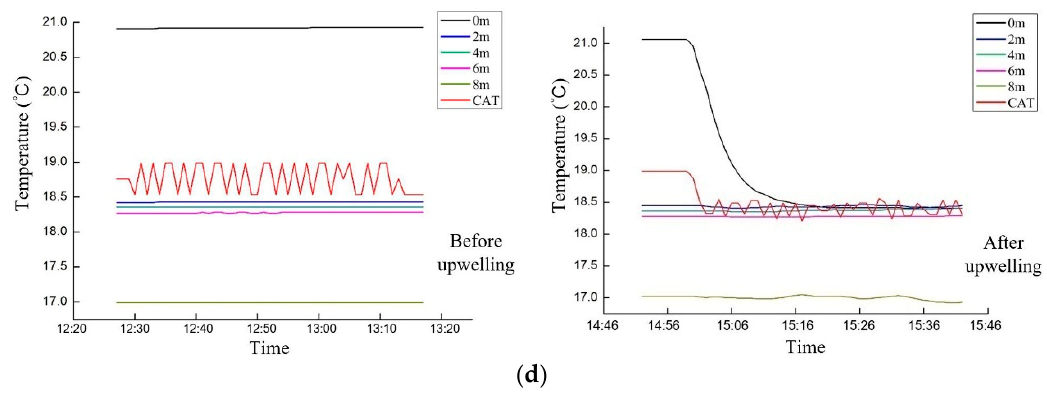
Figure 9. Comparison of CAT results with temperature sensor results. ( a ) The results comparison for right triangle layout; ( b ) The results comparison for isosceles triangle layout; ( c ) The results comparison for rectangular layout; ( d ) The results comparison for lozenge layout.